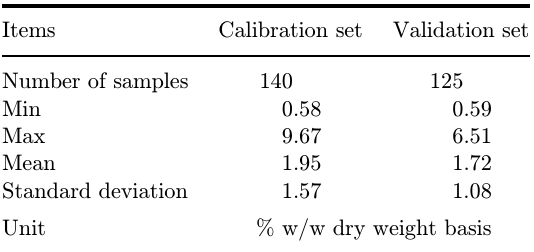
Table 1. Characteristics of calibration and validation sample sets of raw rubber sheet